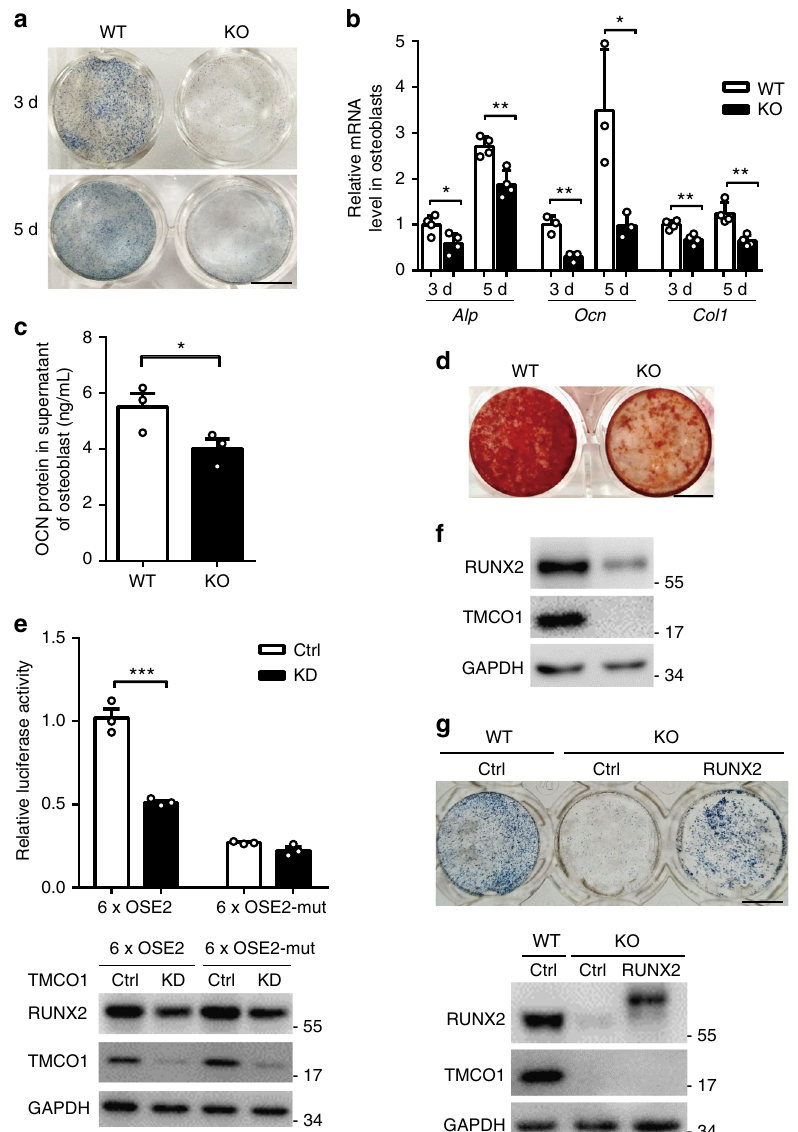
Fig. 2 TMCO1 de fi ciency impairs osteoblast function. a Representative images of ALP staining of WT and Tmco1 − / − osteoblasts after treatment with osteoblast differentiation medium for 5 days. Scale bars, 6mm. b Q-PCR analysis of osteoblast-speci fi c genes in primary osteoblasts from newborns cultured in osteogenic medium for 3 and 5 days, n = 3. Representative results of three independent experiments are shown. c ELISA analysis of the amount of OCN protein in the supernatants of WT ( n = 3) and Tmco1 − / − ( n = 3) osteoblasts after treatment with the osteoblast differentiation medium for 5 days. d Alizarin red staining of WT and Tmco1 − / − BMSCs induced with the osteogenic medium for 21 days. Scale bars, 6mm. e Measurement of RUNX2-responsive OSE2 luciferase activity in C3H10T1/2 cells transfected with control-siRNA or TMCO1-siRNA, n = 3. Below is the western blot analysis of RUNX2 and TMCO1 levels in the lysates. All